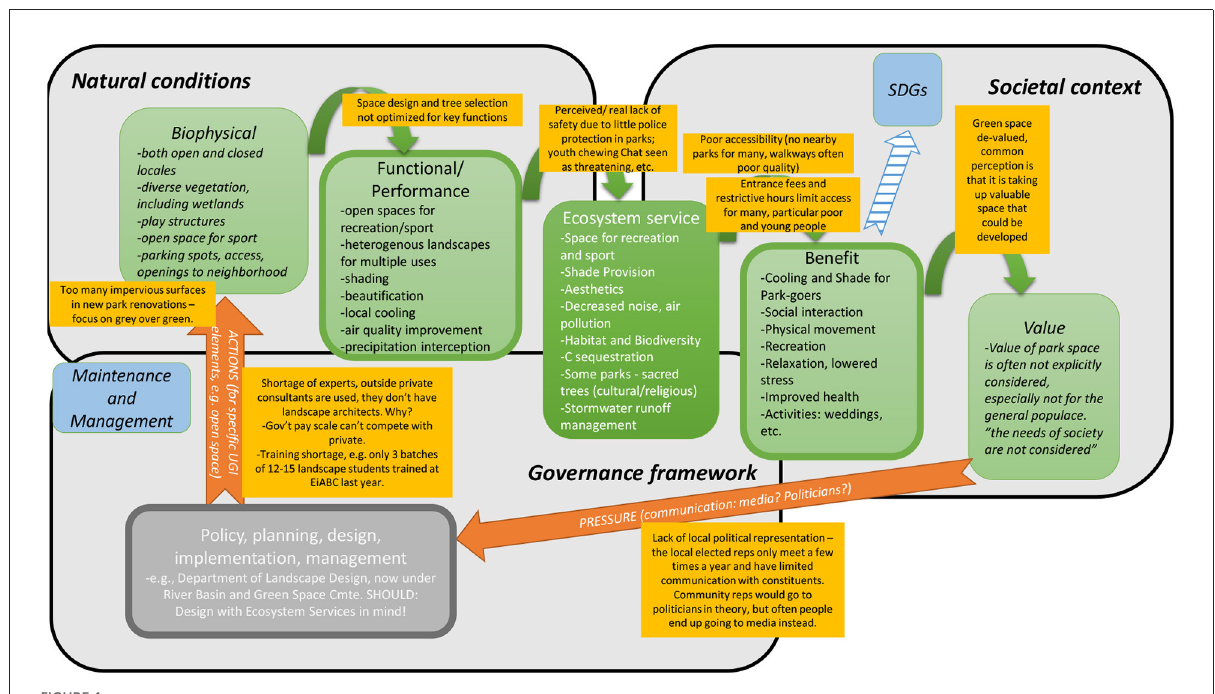
FIGURE4 Example of challenge mapping using the Cascade Model framework—here showing the results of a group interview with Addis Ababa expert stakeholders on the topic of ES provision by city parks in that city. Green boxes show the different aspects of ES provision within the three main domains (biophysical/natural, societal, and governance). Yellow boxes illustrate specific challenges noted, and are located by where they present a “barrier” to the ability of the cascade to proceed to successful ES provision for optimized societal